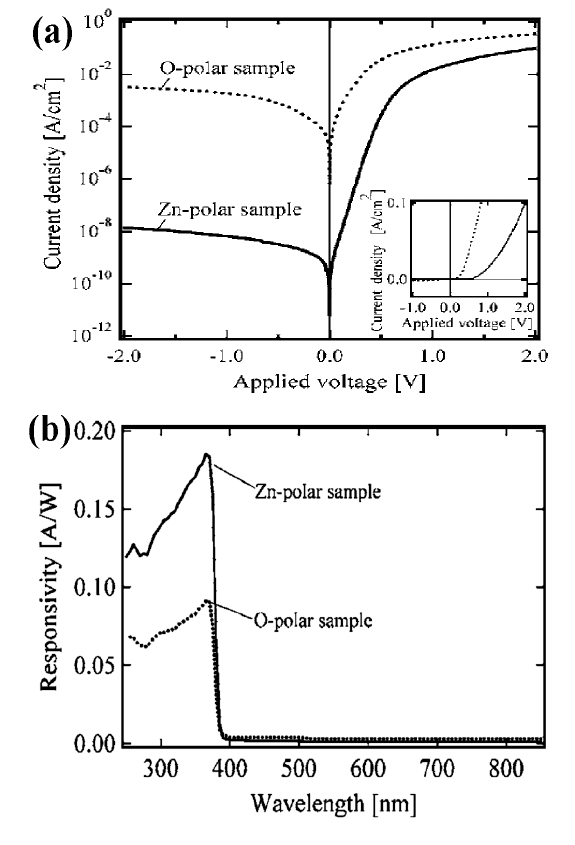
Figure 8. (a) Current-voltage characteristics of the Schottky photodiode with a Pt Schottky semi-transparent electrode on the Zn surface (Zn-polar) and O surface (O-polar). (b) Spectral responsivity of the photodiodes for the Zn-polar and O-polar devices